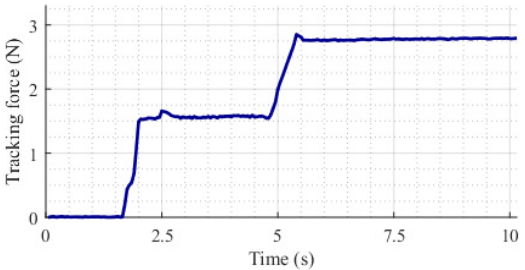
Figure 12. The tracking force in testing the gripping force estimator.